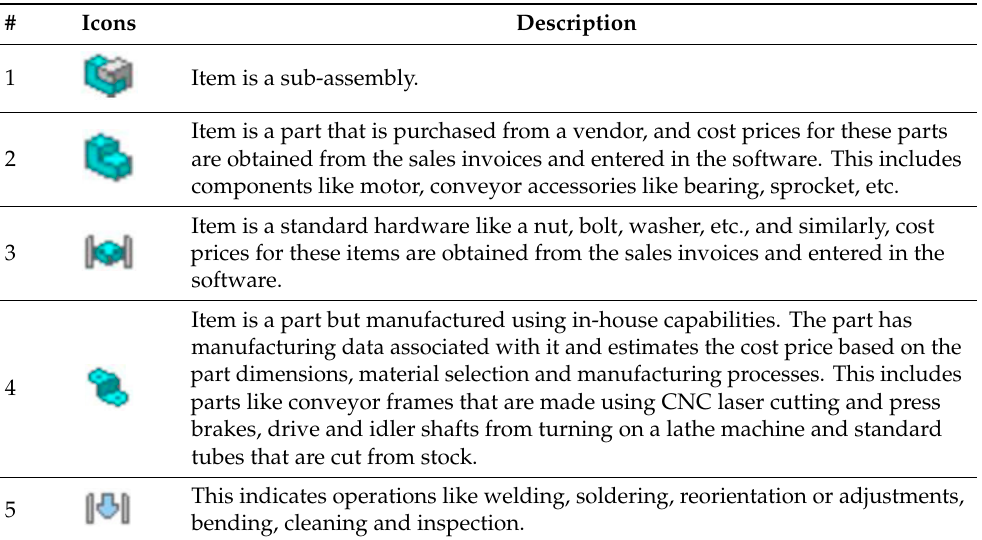
Table 1. Description of icons used in the product structure.